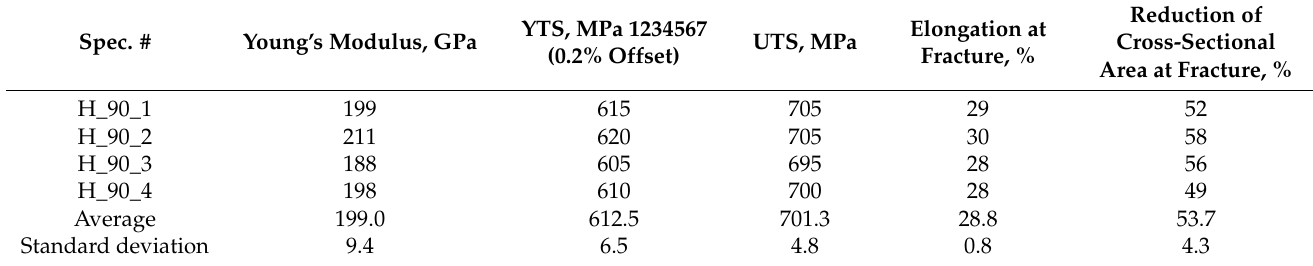
Table 4. The measured mechanical properties of “H_90” set.